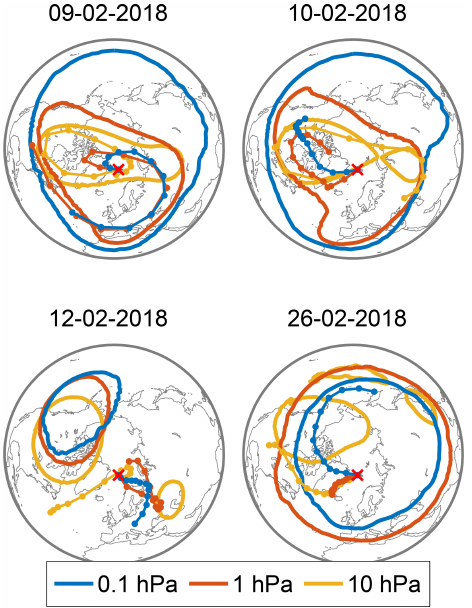
Figure 12. The solid lines indicate the contour of the polar vortex at 10, 1 and 0.1hPa during the major SSW of 2018. The line with dots shows the LAGRANTO 3d backward trajectory at the same altitudes. The red cross indicates the location of Ny-Ålesund.